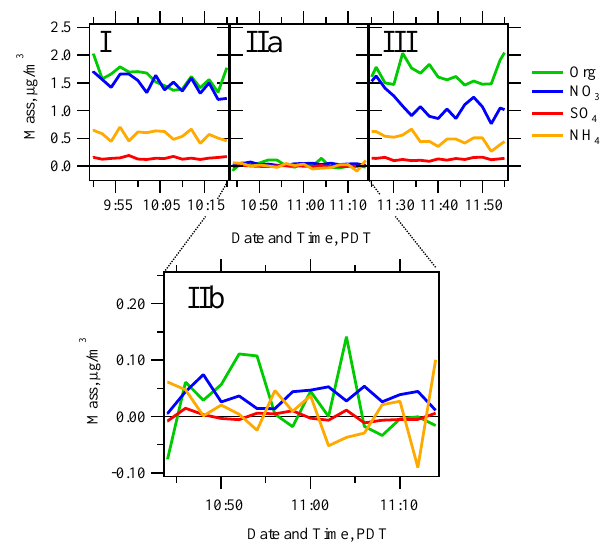
Fig. 7. Time series of organic and inorganic mass determined by AMS measurements. Period (I) is ambient data. Period (II) is the mass measurement after the CCNC and PCVI immediately after Pe- riod (I) . Period (III) is ambient data immediately after Period (II) . Note that Fig. 6, (IIa) has a consistent mass scale with (I) and (III) , and Fig. 6, (IIb) has a 10 × mass